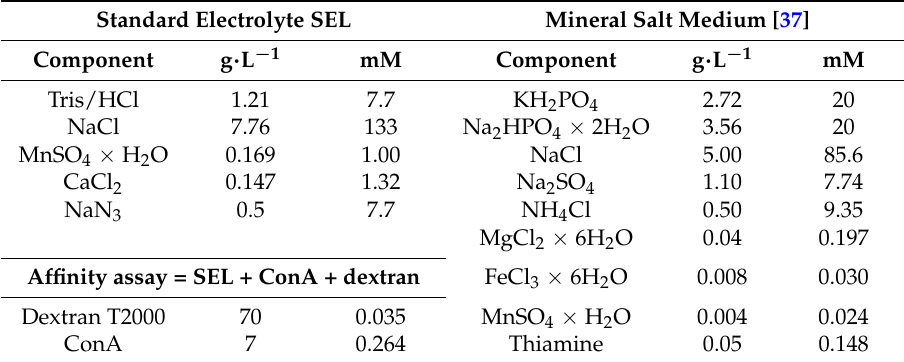
Table 1. Composition of media used. SEL, standard electrolyte.